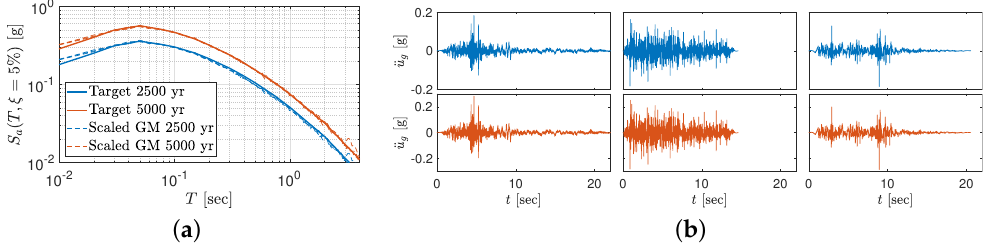
Figure 11. Uniform hazard response spectra and three scaled ground motions for each hazard level. ( a ) Response spectra. ( b ) Ground motion records (left to right: GM1, GM2, and